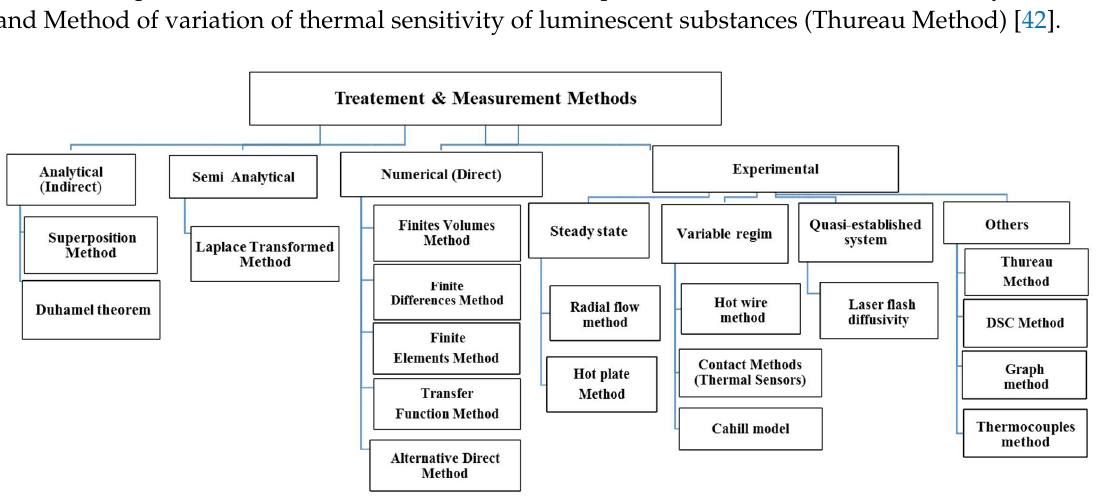
Figure 9. Different techniques of treatment, measurement and calculation in the thermal domain. Adapted from [43].